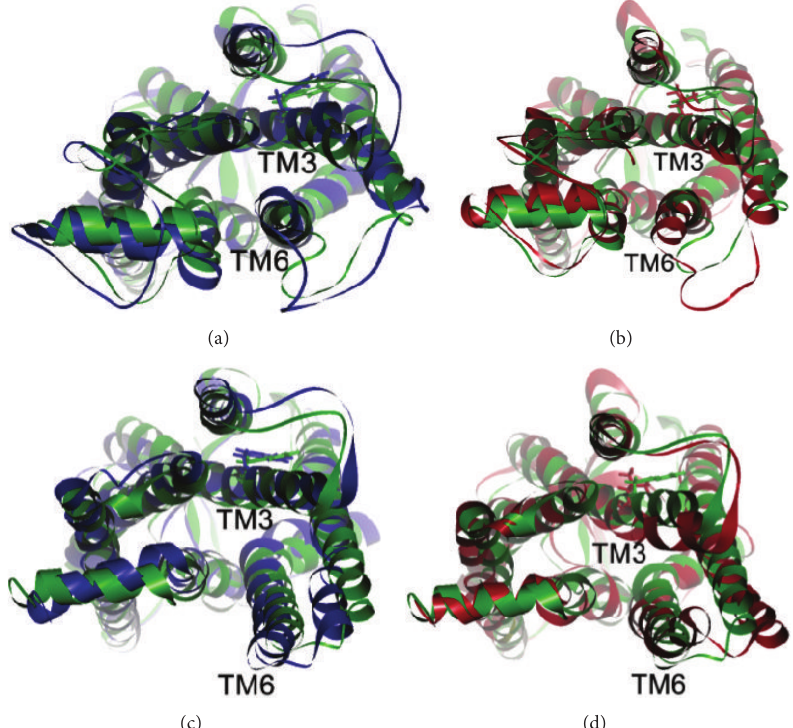
Figure 4: Projected view from the cytoplasmic side of the backbone before and after the 1ns molecular dynamics (MD) simulations. The side chain of the position 126 in each model is shown by the bold sticks in the corresponding colors. (a) Dark-adapted like models. Blue: wild-type after 1ns MD; green: wild-type before MD. (b) Dark-adapted like models. Red: W126L after 1ns MD; green: W126L before MD. (c) Light-adapted like models. Blue: wild-type after 1ns MD; green: wild-type before MD. (d) Light-adapted like models. Red: W126L after 1ns MD; green: W126L before